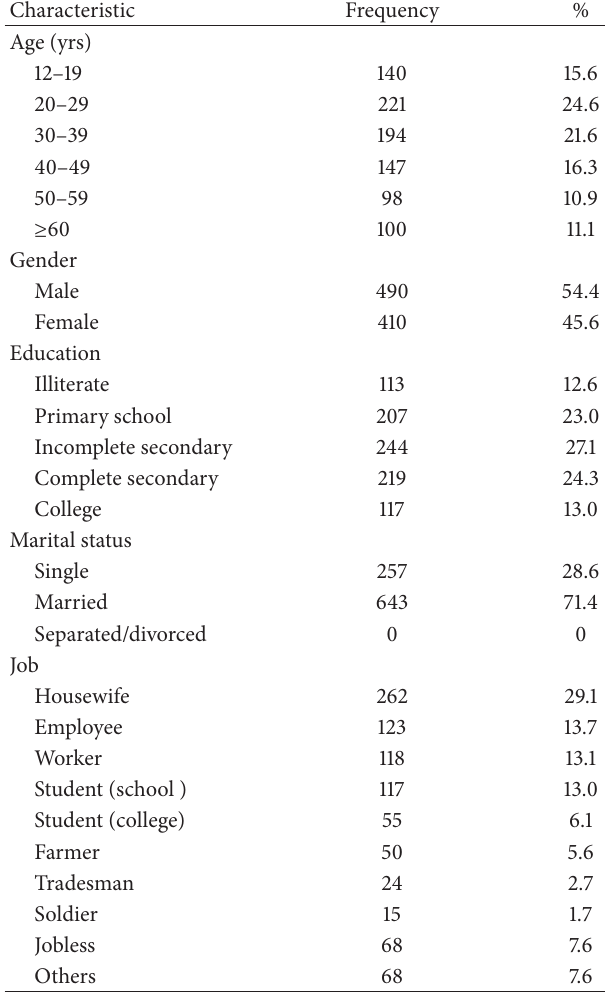
Table 1: Demographic characteristics of rural residents ( 𝑛 = 900